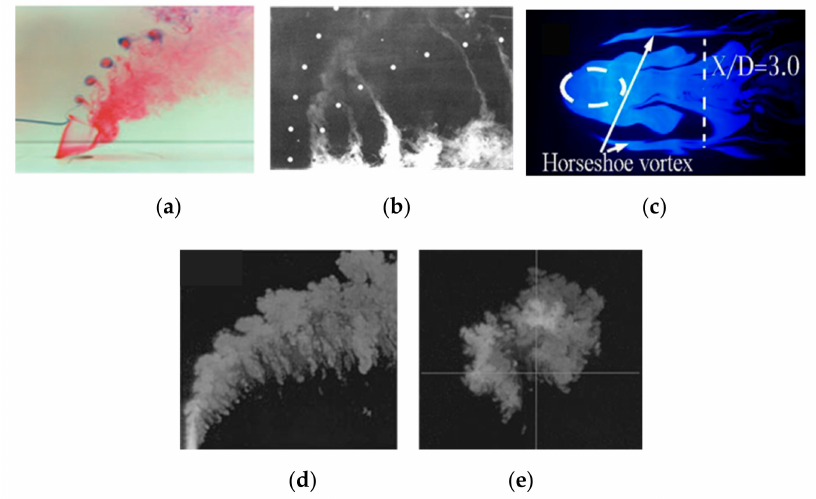
Figure 8. Visualization of various instantaneous flow structures: ( a ) shear-layer vortices [80]; ( b ) tornado-like wake vortices [77]; ( c ) horseshoe vortices upstream of the jet [22]; and ( d , e ) in- stantaneous counter-rotating vortex pair (CRVP) visualization of jet fluid for r = 10.0 (Panels d and e taken from Smith and Mungal [83]).